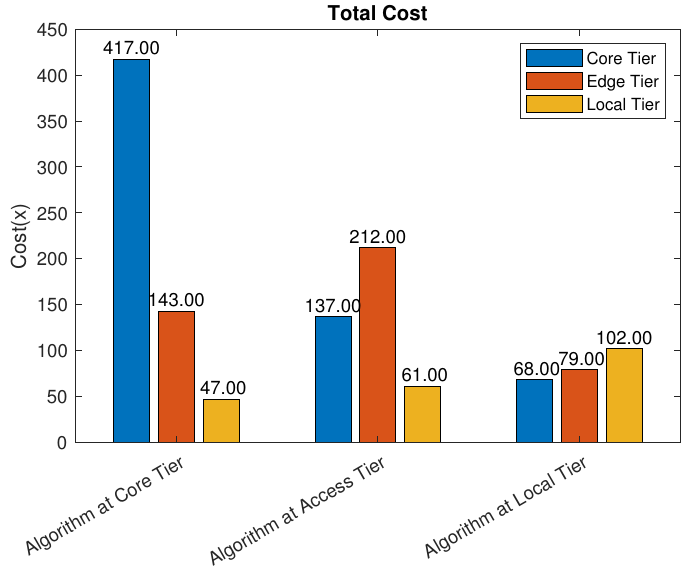
Figure 11. Total cost: with the blockchain.